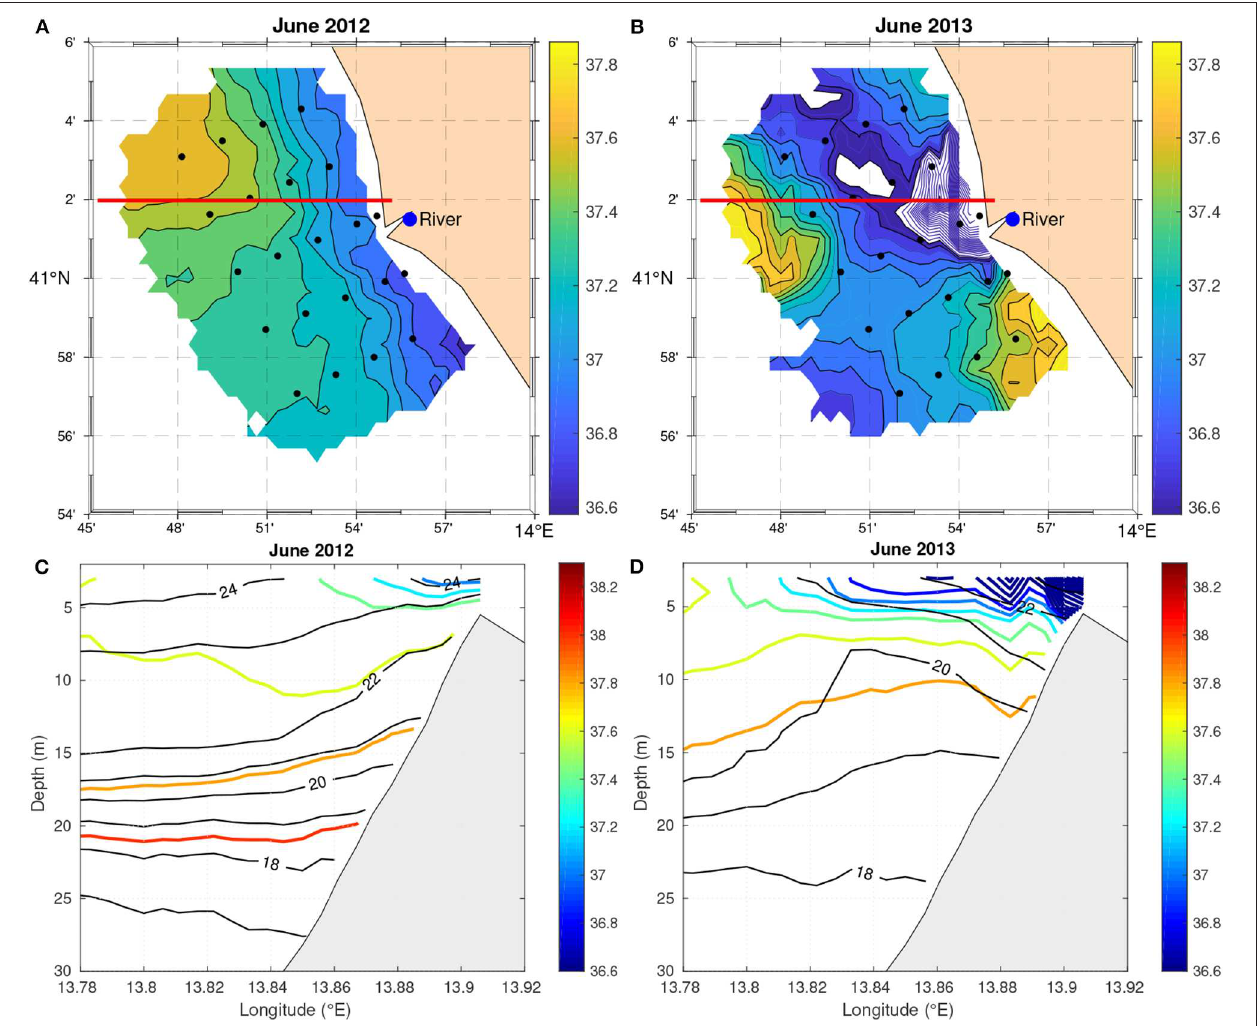
FIGURE 7 | OA maps of salinity ( g kg − 1 ) at 3 m (A,B) in June 2012 (left panel) and June 2013 (right panel). The fields are not plotted where the OA expected error exceeds 20 % . The contour interval is 0.1 g kg − 1 . In (B) , the salinity below 37 g kg − 1 is in correspondence with the three casts in front of the river mouth. It is not drawn to highlight the other structures. Dots indicate location of casts. In (C,D) , the vertical isolines of temperature (in black, contour interval 0.05 ◦ C) and salinity (colored, contour interval 0.05 g kg − 1 ) are shown for both along the 41 ◦ 02’ N parallel (red line).